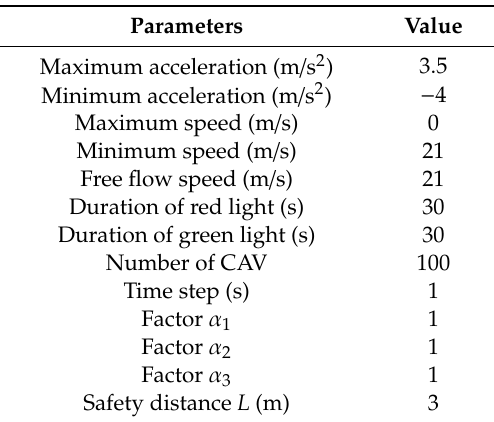
Table 4. Attributes in the